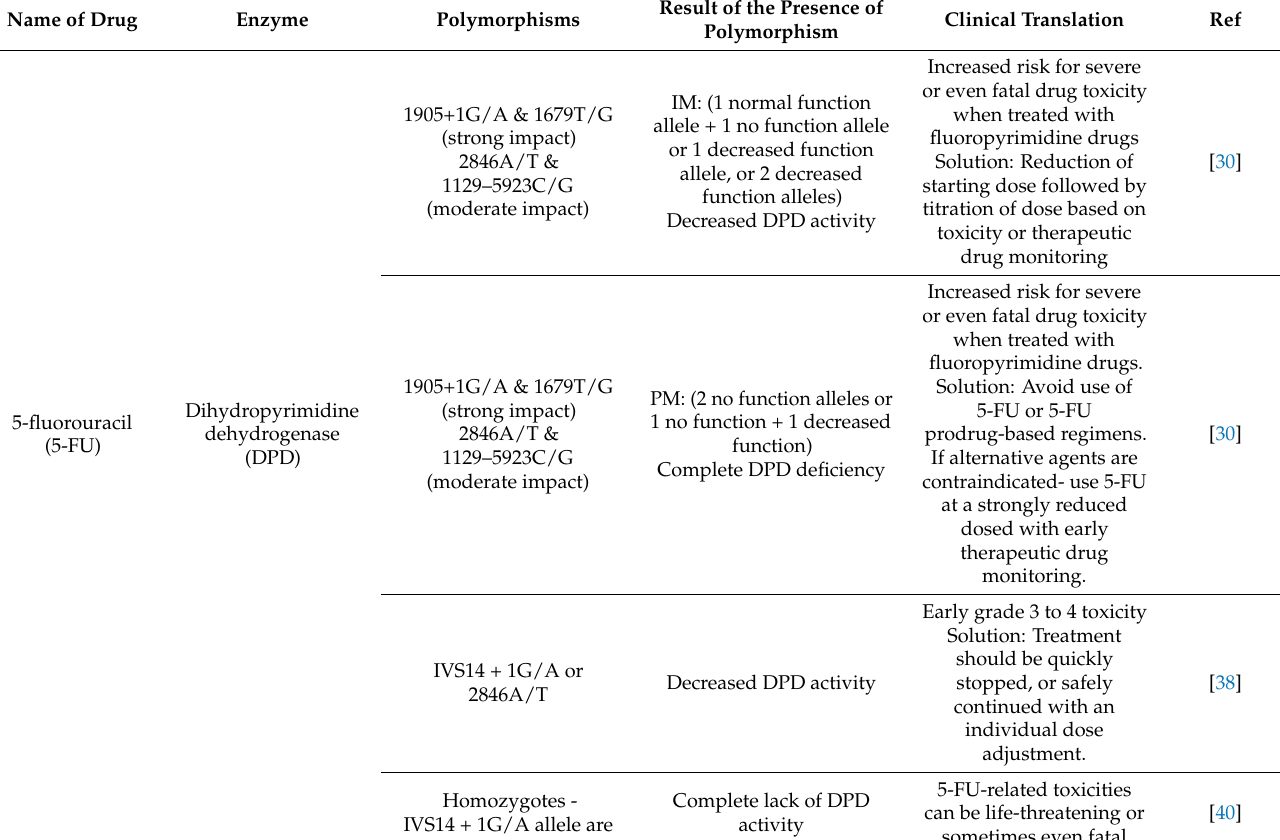
Table 1. The summary of studies concerning the impact of polymorphisms within genes encoding enzymes involved in the metabolism of drugs on therapeutic